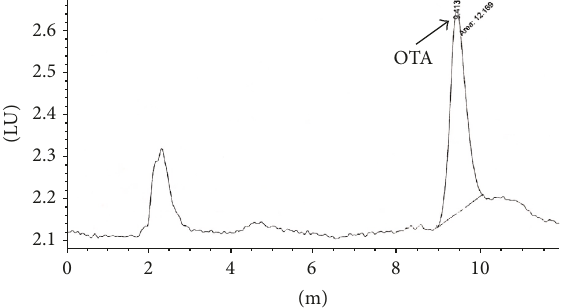
Figure 2: HPLC chromatogram of OTA